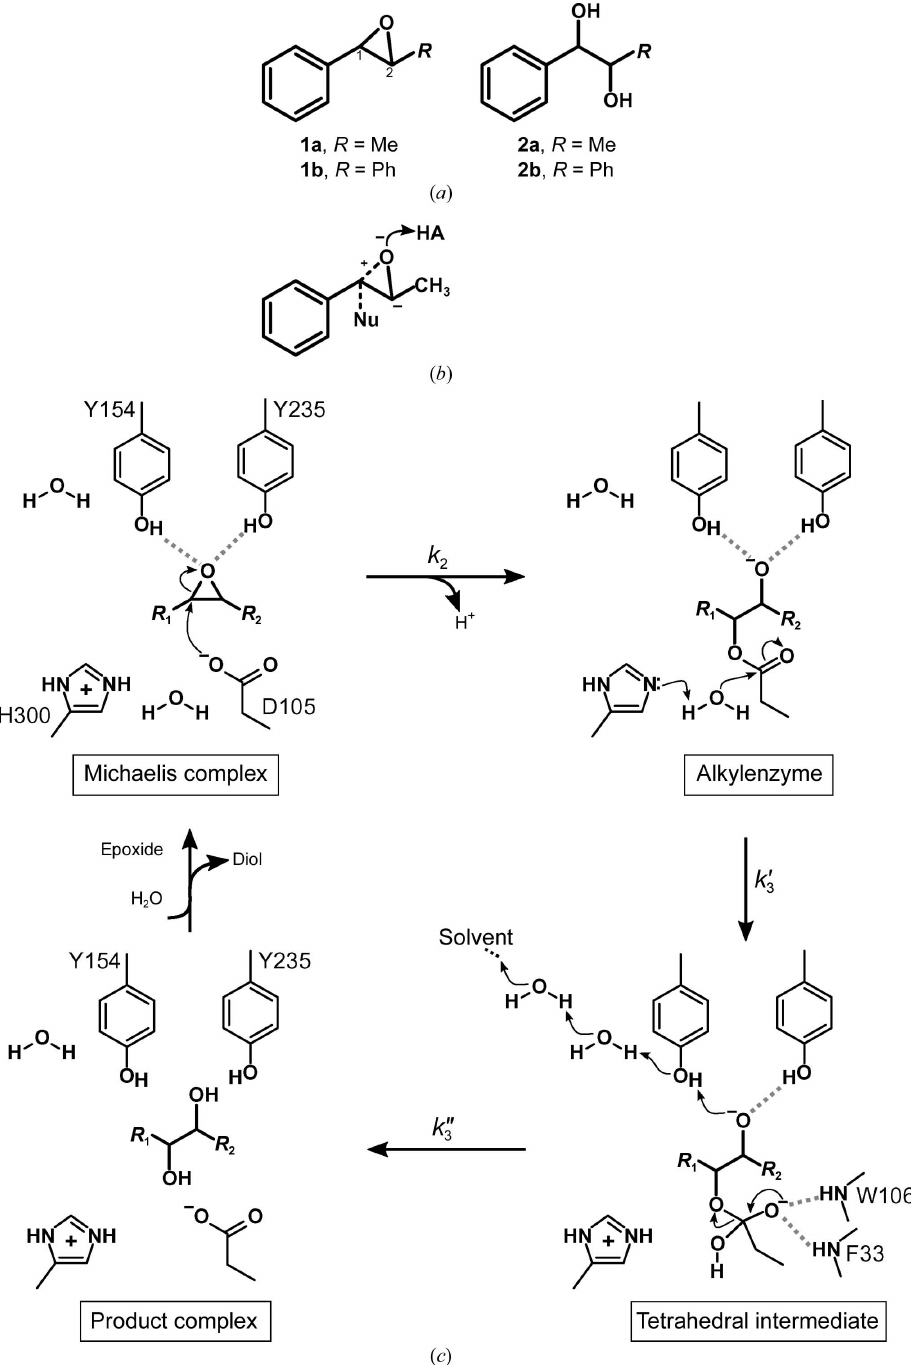
philic attack on one of the oxirane C atoms. The formed oxyanion is stabi- lized by the phenol groups of Tyr154 and Tyr235. This alkylenzyme inter- mediate is subsequently hydrolyzed by a base-activated (His300) water. See Fig. 4 for the location of these catalytic residues within the active site. The transient presence of the alkylenzyme can be detected from quenching of the intrinsic protein fluorescence, allowing estimation of its rates of formation ( k 2 ) and decay ( k 3 ). The rate of formation of the tetrahedral intermediate ( k 0 3 in the figure) is expected to be rate-deter- mining for hydrolysis of the alkyl- enzyme, due to the intrinsic instability of this intermediate ( k 00 3 (cid:3) k 0 3 ). Note that, formally, k 3 measures all steps involved from hydrolysis of the alkyl- enzyme to product release; hence, this has been divided into k 0 3 and k 00 3 for